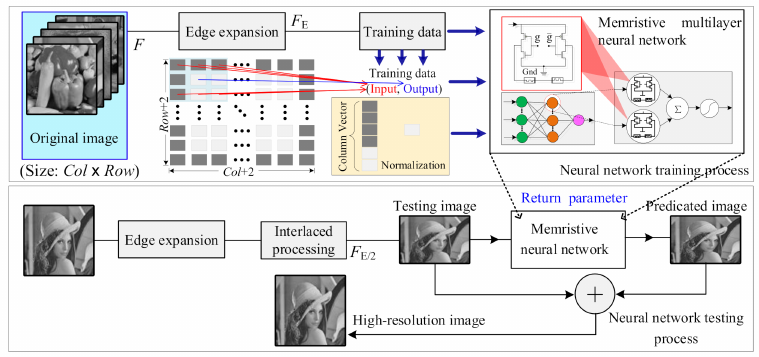
Figure 8. Single frame image super-resolution reconstruction based on memristive